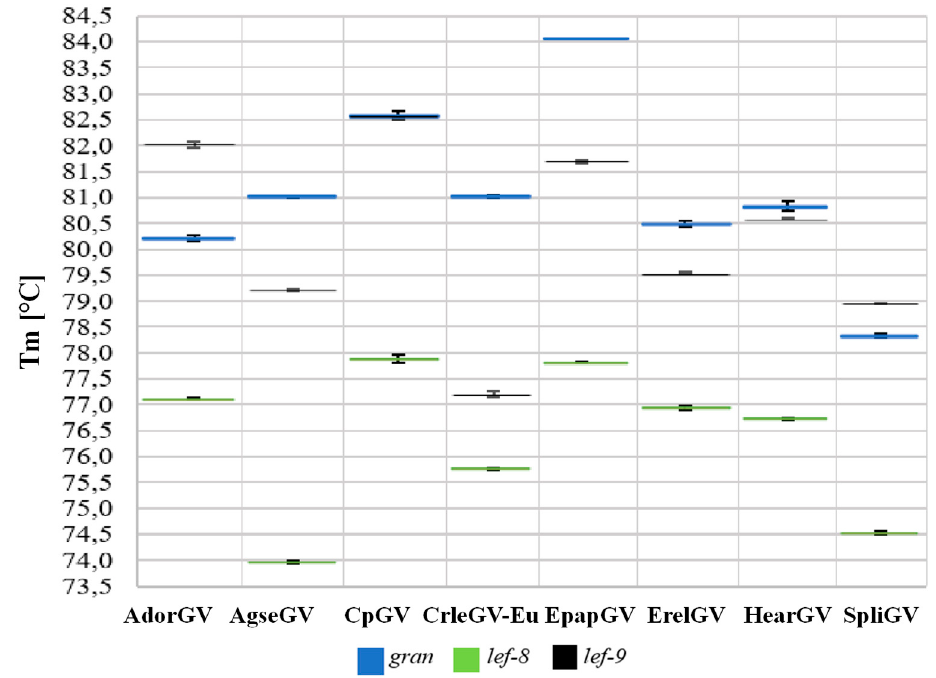
Figure 6. Schematic representation of the results of the described real-time PCR-based method for differentiation of betabaculovirus species based on three genes: gran, lef-8, and lef-9 . Each line represents Tm for real-time PCR products ( gran —blue, lef-8 —green, and lef-9 —black) with SD values.